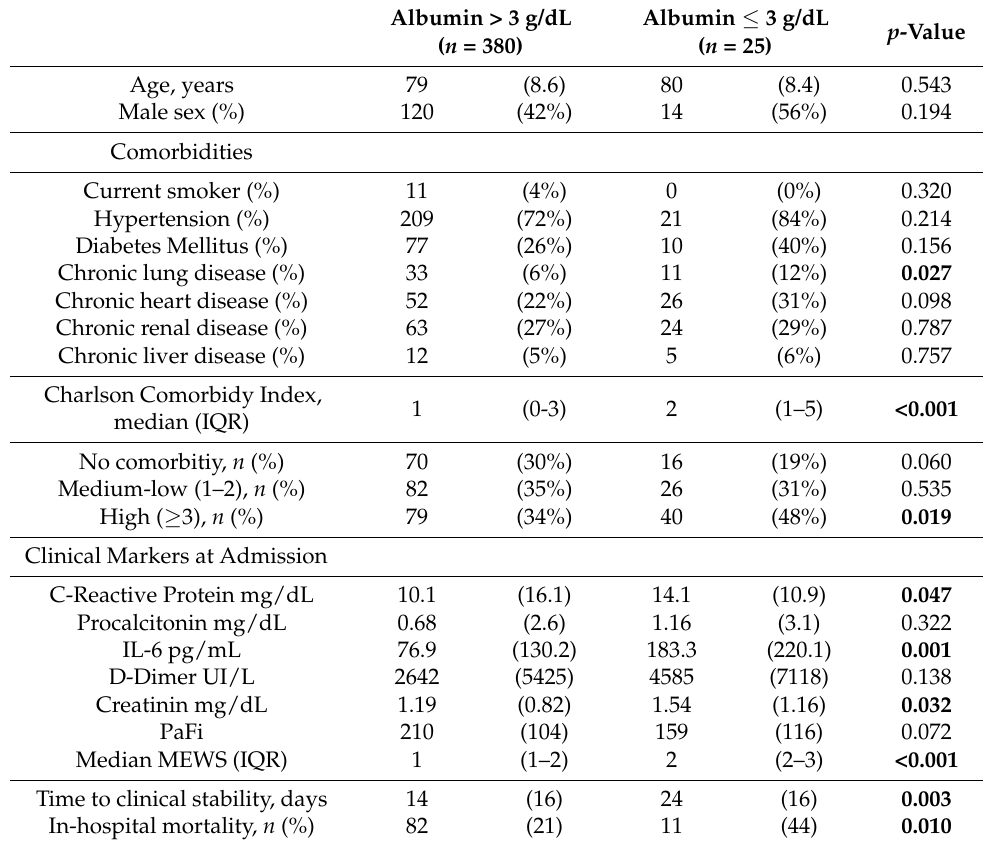
Table 2. Clinical differences between older adults with SARS-CoV-2 infection with serum albumin at admission >3 g/dL vs. ≤ 3